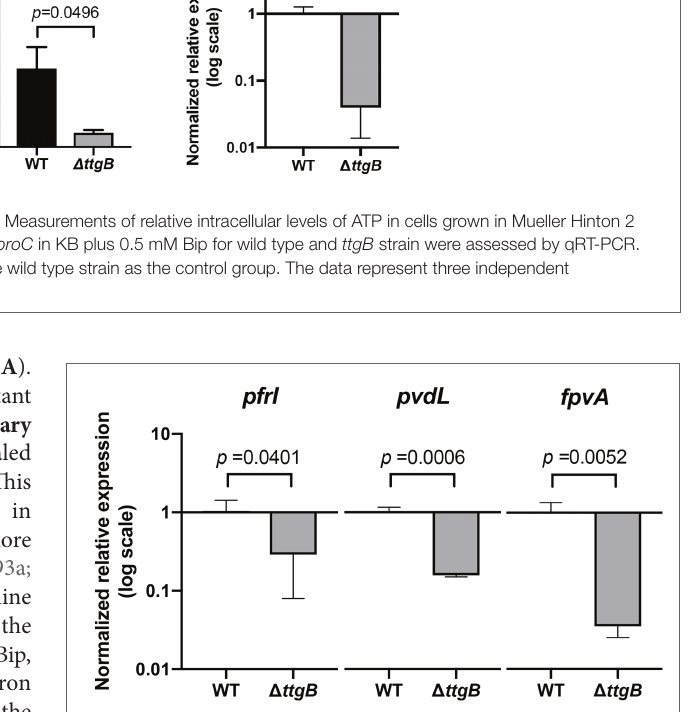
FIGURE 4 | Expression levels of pyoverdine-related genes in the ttgB mutant are affected by Bip. Relative expression levels of pfrI , pvdL , and fpvA in KB plus 0.5 mM Bip were assessed by quantitative real time PCR (qRT-PCR). The target genes were normalized against the reference gene ( rpoD ) using the wild type strain as the control group. The data represent three independent experiments.